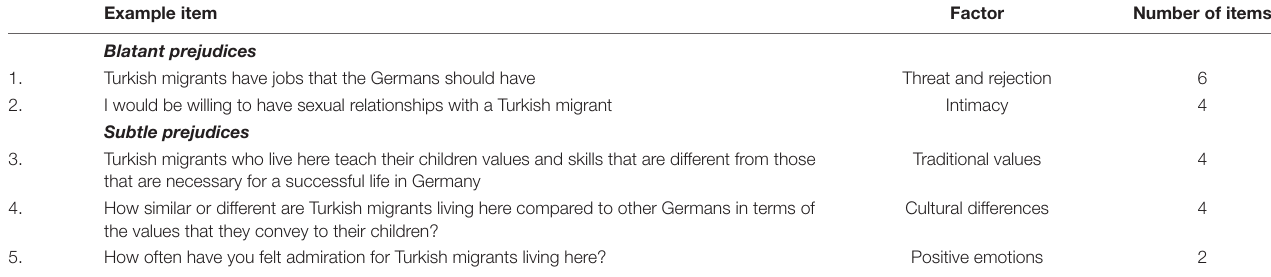
FIGURE 1 | (A) Trial configuration: In each trial, subjects had to make two consecutive choices. At a first stage (gray boxes), subjects chose one stimulus over the other (e.g., horizontal ellipse over vertical ellipse) and then proceeded to a second stage (colored boxes: either green or yellow stimulus pair) where they chose between two stimuli. Second stage choices were probabilistically rewarded or punished according to Gaussian random walks. In the depicted example the most right stimulus has a 73% of being rewarded. Transition probabilities between first and second stages varied for first stage choices: Whereas one stimulus choice led commonly (70% of all trials) to one second stage stimulus pair and rarely (30% of all trials) to the second stage stimulus pair, the opposite was true for the other first stage choice. (B) Reward probabilities for second stage choices. The example in (A) are the outcome probabilities for all four second stage stimuli at trial 150 (red dashed line in (B) ). (C) Expected stay probabilities for pure model-free and pure model-based control. Only model-based control predicts the use of the transition structure of the task (common vs. rare trials) to make choices. Imagine in the example trial 2A that a subject chooses the horizontal ellipse in the first stage, then ends in the rare yellow second stage and selects the “flash-like” stimulus, which is then rewarded. Model-free control predicts a repetition of the first stage choice (horizontal ellipse) in the next trial. However, model-based control predicts a switch to the opposing first stage stimulus (vertical ellipse) in the next trial, because this stimulus has a higher probability in leading to the yellow second stage, where the subject can again choose the flash-like stimulus. Thus, model-free and model-based control make distinct predictions about next trials’ first stage choice behavior after rare trials. TABLE 2 | Example items for blatant and subtle prejudices of the blatant and prejudice scale (Pettigrew and Meertens, 1995). Example item Factor Number of